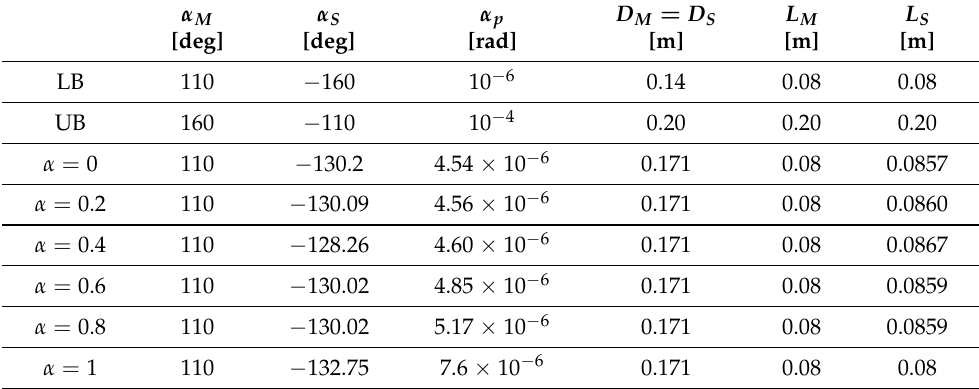
Table A1. The resulting (optimized) parameter values of co-design case 1 given variable weight α